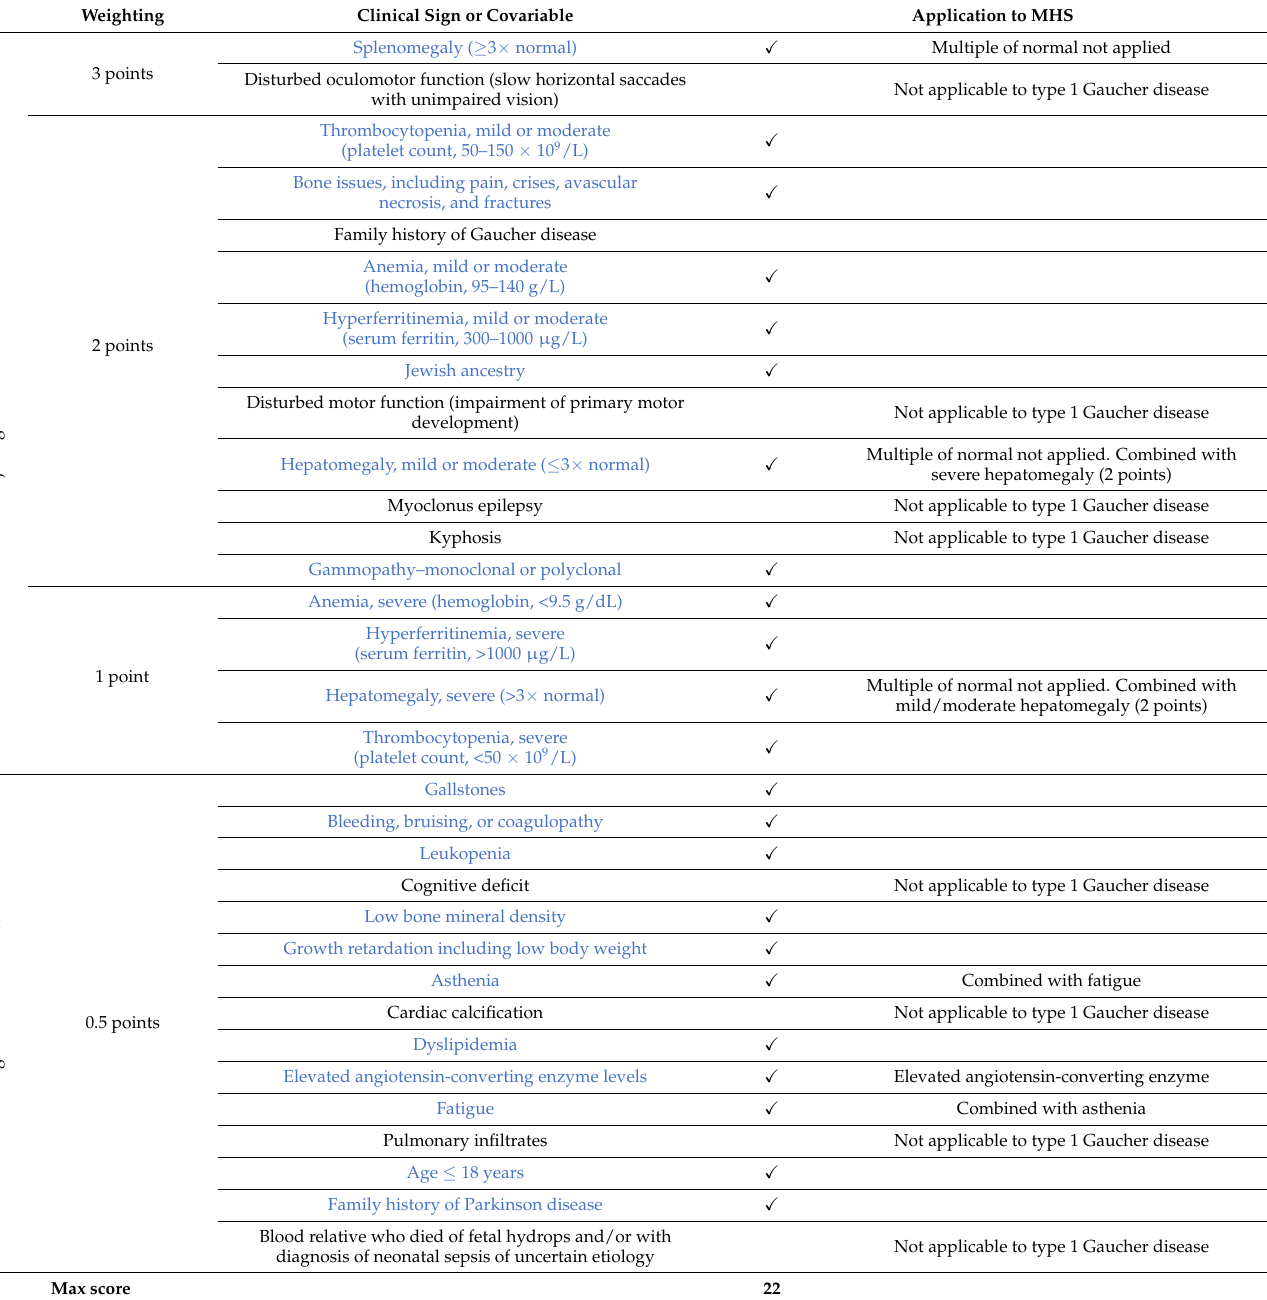
Table 1. The GED-C scoring